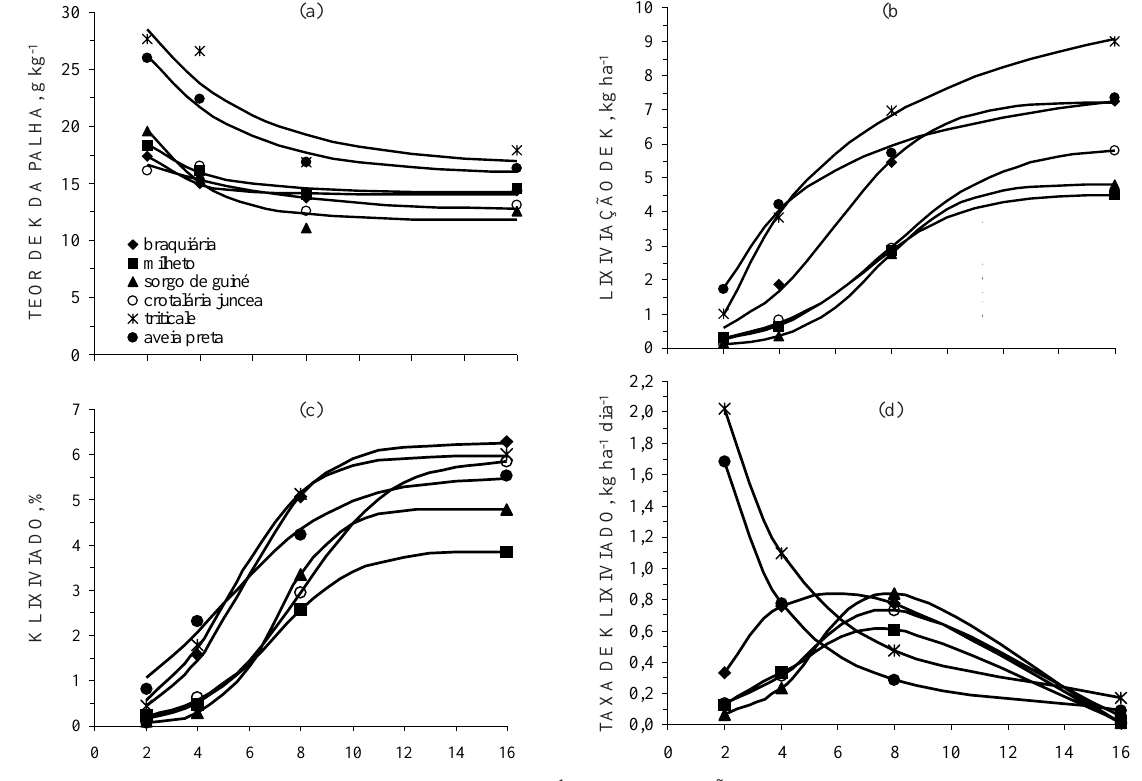
Figura 3. Teores de K das palhas de plantas de cobertura, antes de serem submetidas à simulação de chuva, ao longo do período de senescência após o manejo químico (a). Lixiviação de K das palhas, conforme a época de simulação de chuva após a dessecação (b). Percentagem de K lixiviado, em relação ao total de K acumulado na parte aérea das seis espécies de cobertura (c). Taxa diária de lixiviação de K de palhas de plantas de cobertura, conforme a simulação de chuva (d). Valores observados (símbolos) e valores estimados